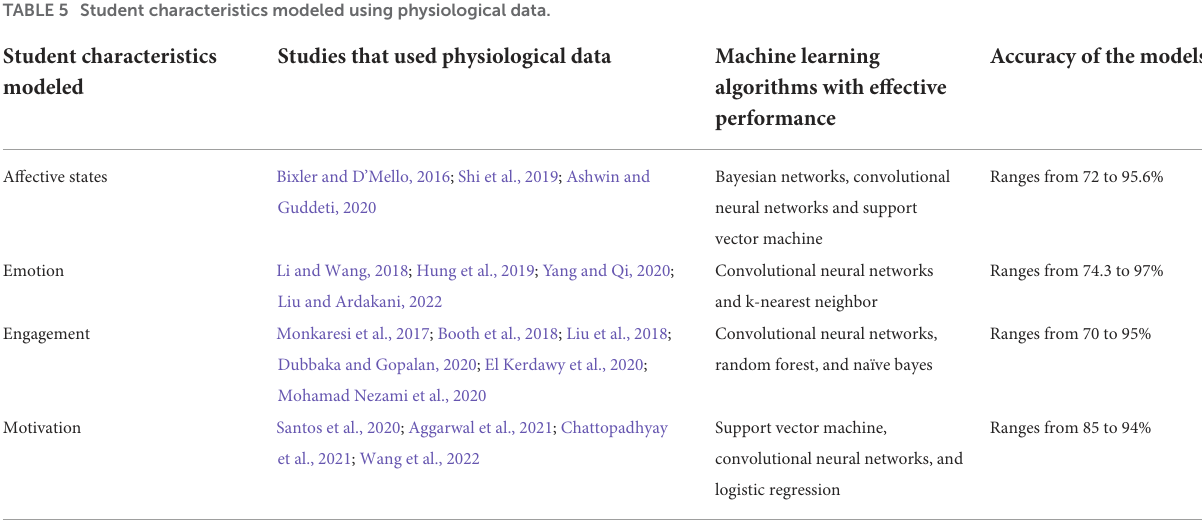
TABLE 5 Student characteristics modeled using physiological